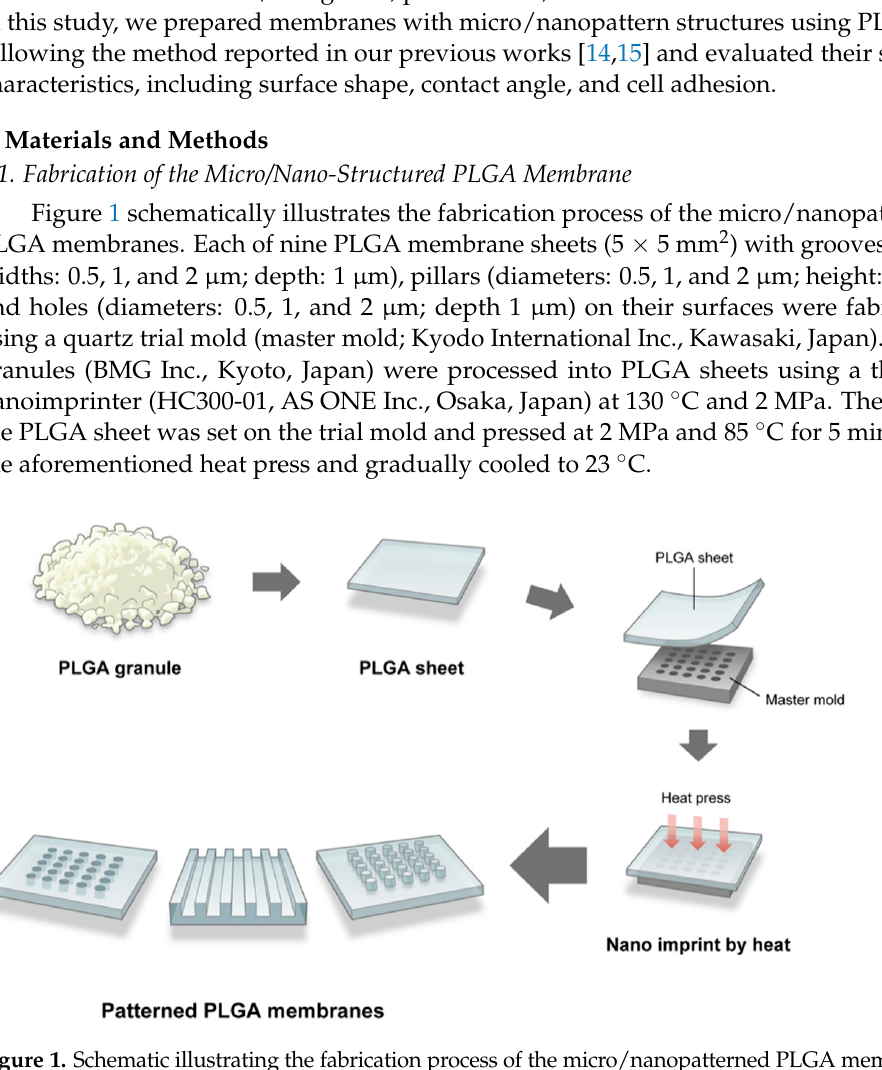
Figure 1. Schematic illustrating the fabrication process of the micro/nanopatterned PLGA membranes.